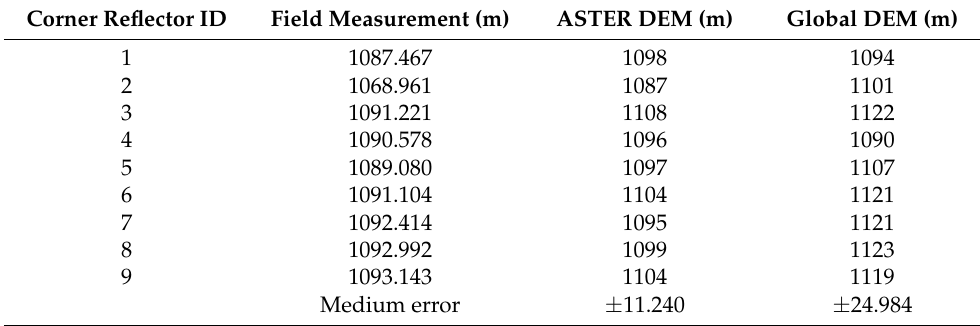
Table 5. Elevation errors of different elevation sources.